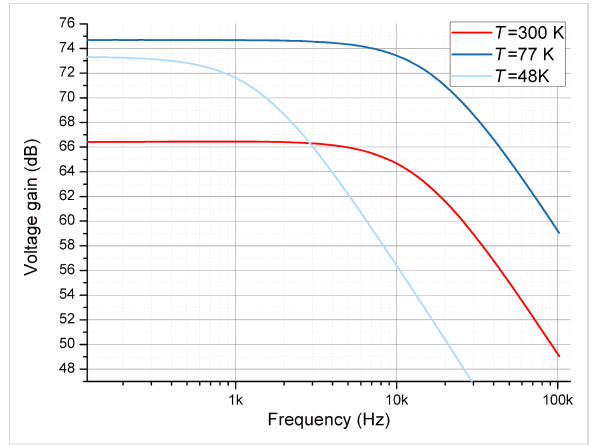
Figure 4: The gain of the cryogenic differential two-stage BJT ampli- fier as a function of the frequency at three different temperatures.